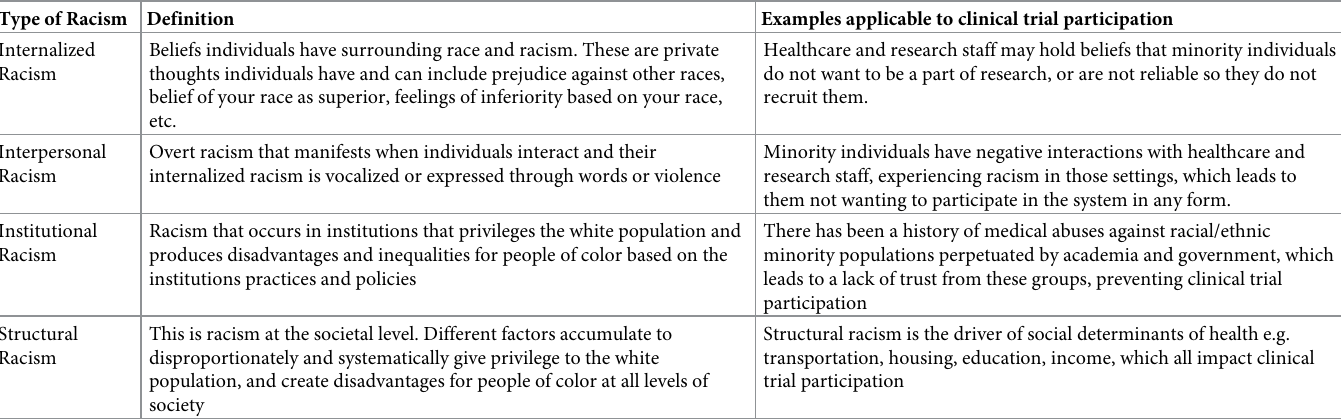
Table 5. Definitions for types of racism